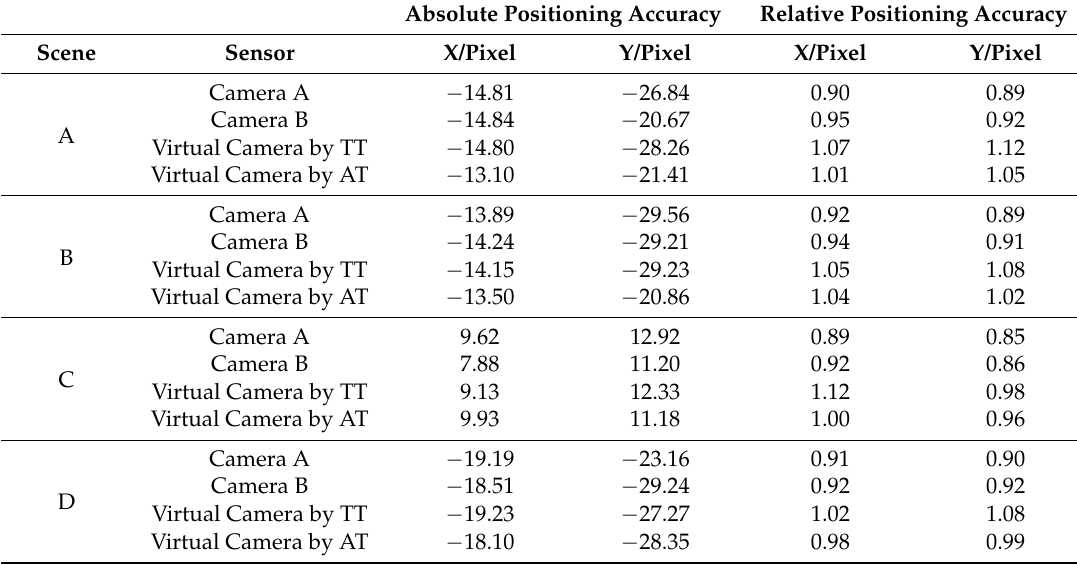
Table 5. Geometric accuracy evaluation of the complete stitched